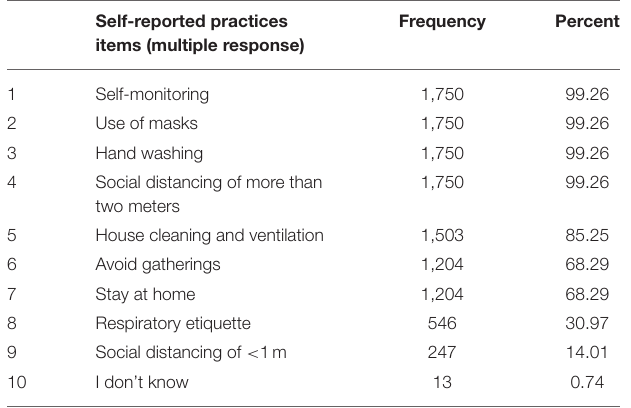
TABLE 4 | Reported practices to prevent the spread of COVID-19 among Ugandans. Self-reported practices items (multiple response)